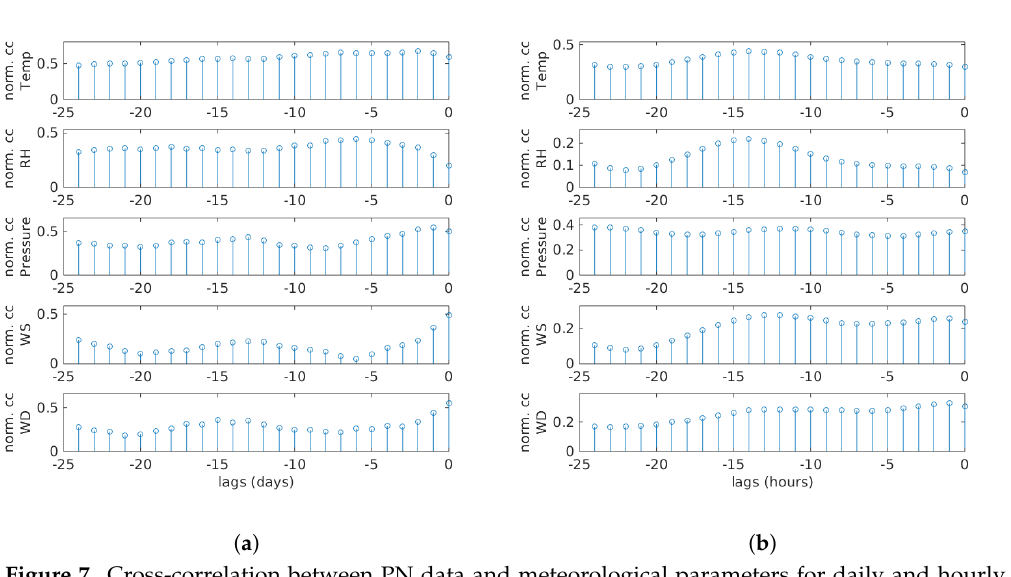
Figure 7. Cross-correlation between PN data and meteorological parameters for daily and hourly averaged data. Different time lags are shown on the x-axis, whereas the y-axis represents normalized correlation coefficients (norm. cc). ( a ) Daily. ( b )